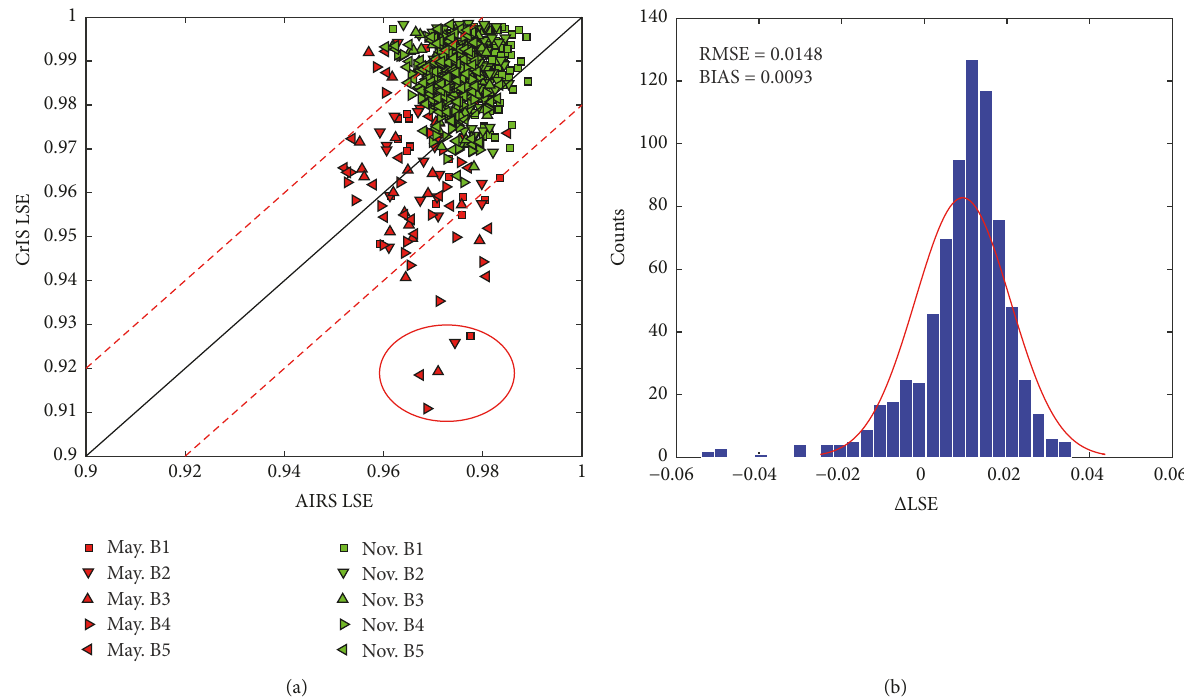
Figure 4: The comparisons of LSEs between CrIS and AIRS: (a) scatterplots of LSEs in five bands for 2 months; (b) histograms of LSE differences between CrIS and AIRS. The red dashed lines mean the points that have a LSE difference of 0.02; the points circled with red solid lines are the singular